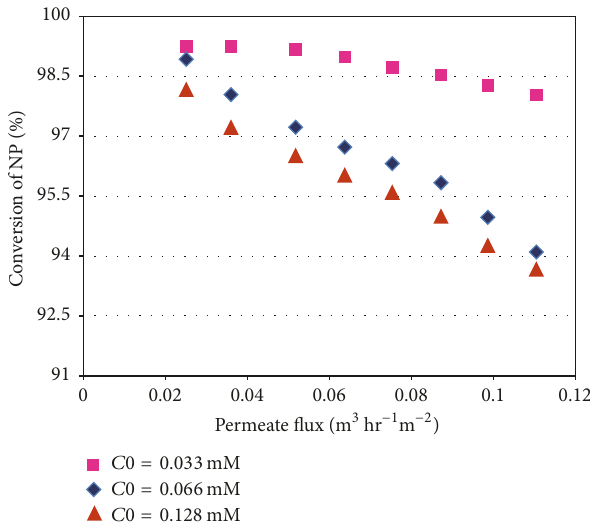
Figure 6: Conversion of nitrophenol (NP) in Pd loaded PES membrane versus flux for single pass in dead-end mode of filtration (0.283 mg of palladium).